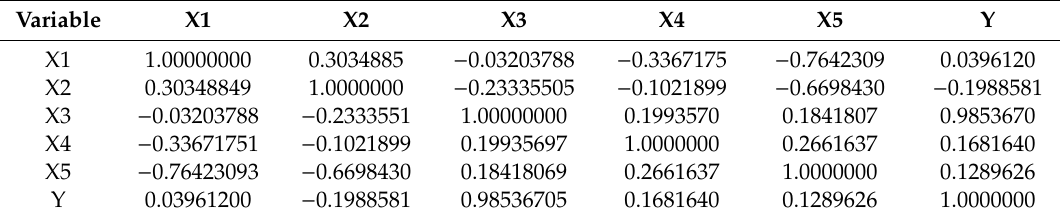
Table 5. Correlation matrix.